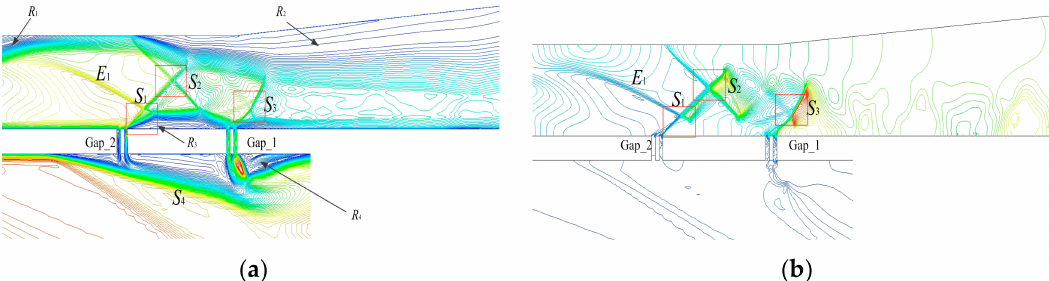
Figure 17. Isolines of Model C local parameters. ( a ) Mach number. ( b )